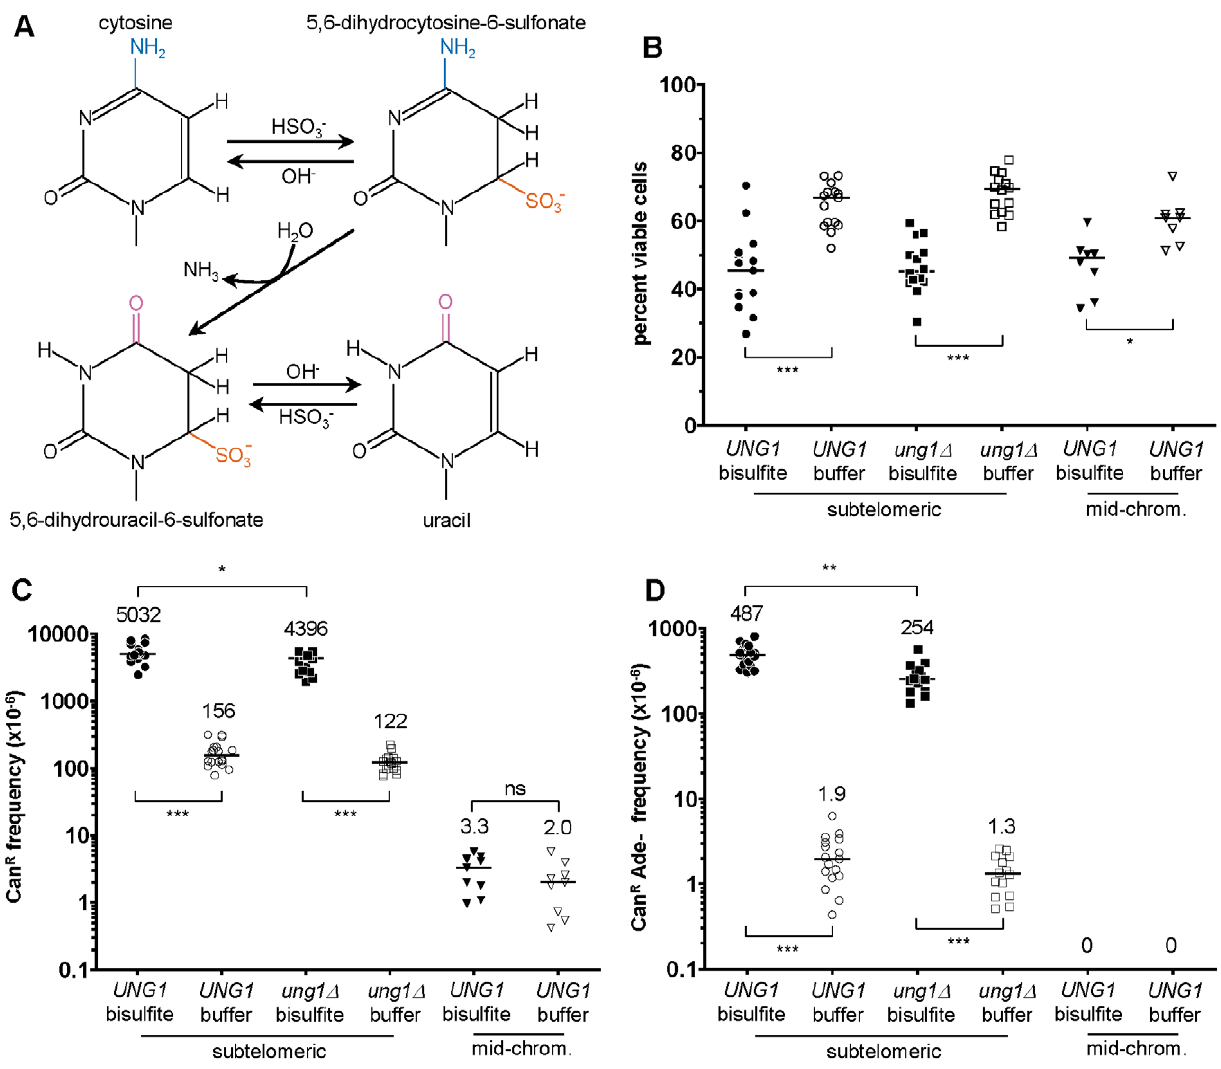
Figure 4. 1% sodium bisulfite is a strong ssDNA–specific mutagen in vivo. (A) Chemical mechanism for bisulfite-mediated conversion of cytosine to uracil. Bisulfite anion reacts with cytosine at C6 to generate 5,6-dihydrocytosine-6-sulfonate, which in turn, undergoes irreversible hydrolytic deamination at C4 to generate 5,6-dihydrouracil-6-sulfonate. Finally, 5,6-dihydrouracil-6-sulfonate is desulfonated by reaction with hydroxide anion to form uracil. (B) Treatment with 1% sodium bisulfite resulted in a modest decrease in viability, with a median value of , 45%. Buffer only controls exhibited a median viability of at least 60%. (C) 1% sodium bisulfite induced a 32- and 36-fold increase in the frequency of CAN1 loss of function when ssDNA was formed, for UNG1 and ung1 D cells, respectively. Notice that there is no induced mutagenesis in mid-chromosome (i.e. dsDNA) controls. (D) 1% sodium bisulfite induced 250- and 195-fold increases in the frequency of simultaneous CAN1 and ADE2 double loss of function within ssDNA, for UNG1 and ung1 D cells,